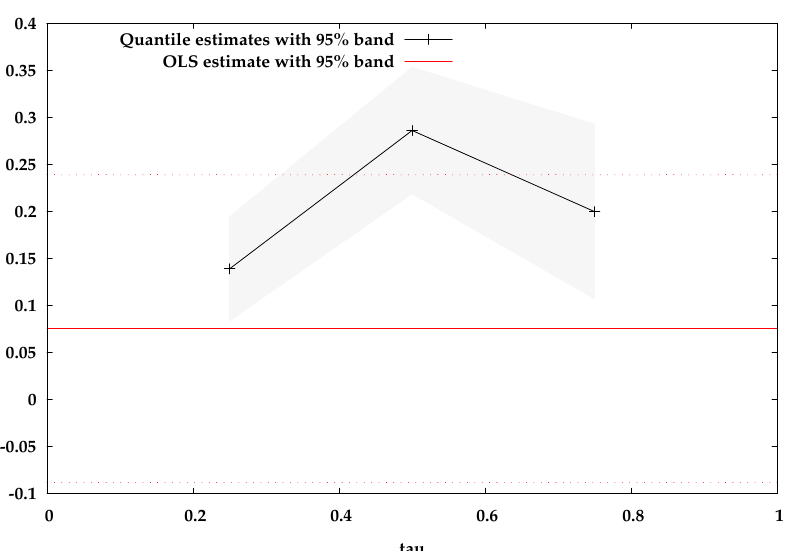
Figure 8. Coefficients across the quantiles with the bootstrapped confidence intervals for regression of downside beta coefficient vs. downside beta coefficient for ROA ( τ = 0.25;0.5;0.75, the OLS confidence interval is from − 0.0884 to 0.2389).